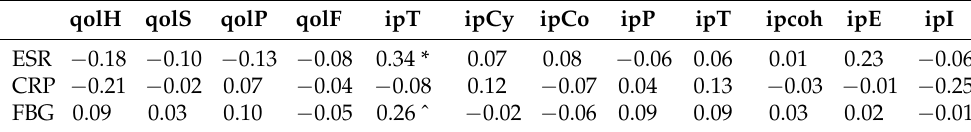
Table 7. Correlations between quality of life, illness perception dimensions and inflammatory